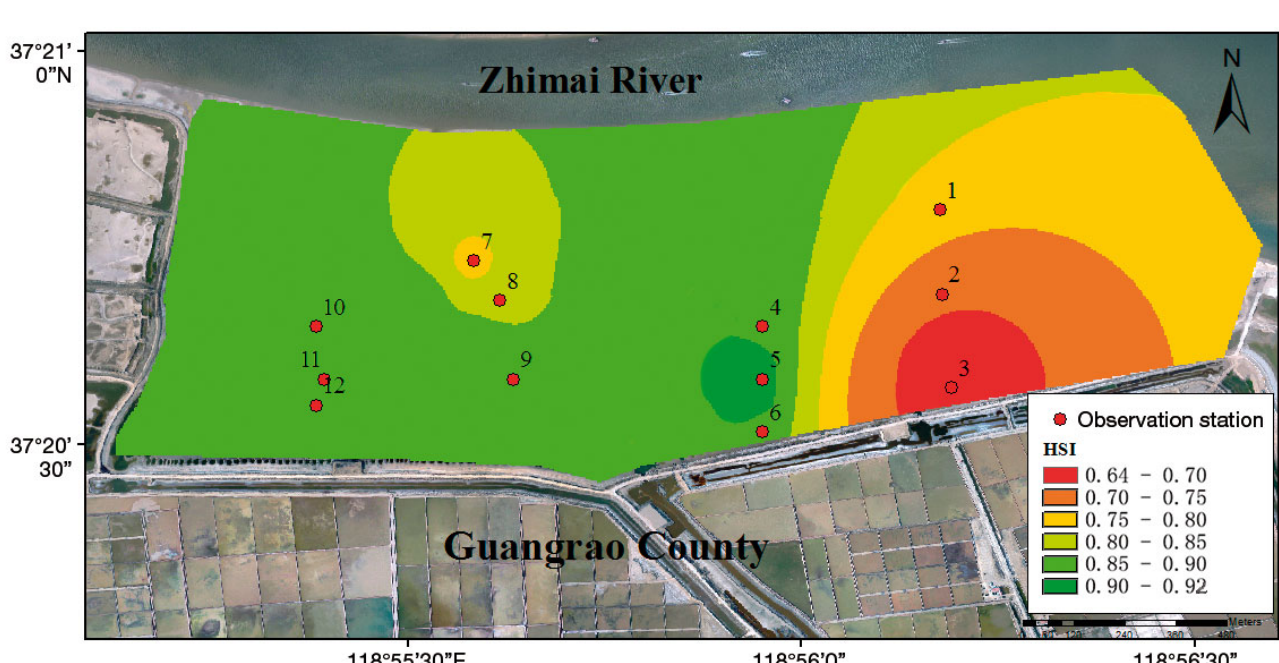
Fig. 4. Habitat suitability map for Perinereis aibuhitensis in the estuarine wetlands of the Zhimai River. HSI: habitat suitability index